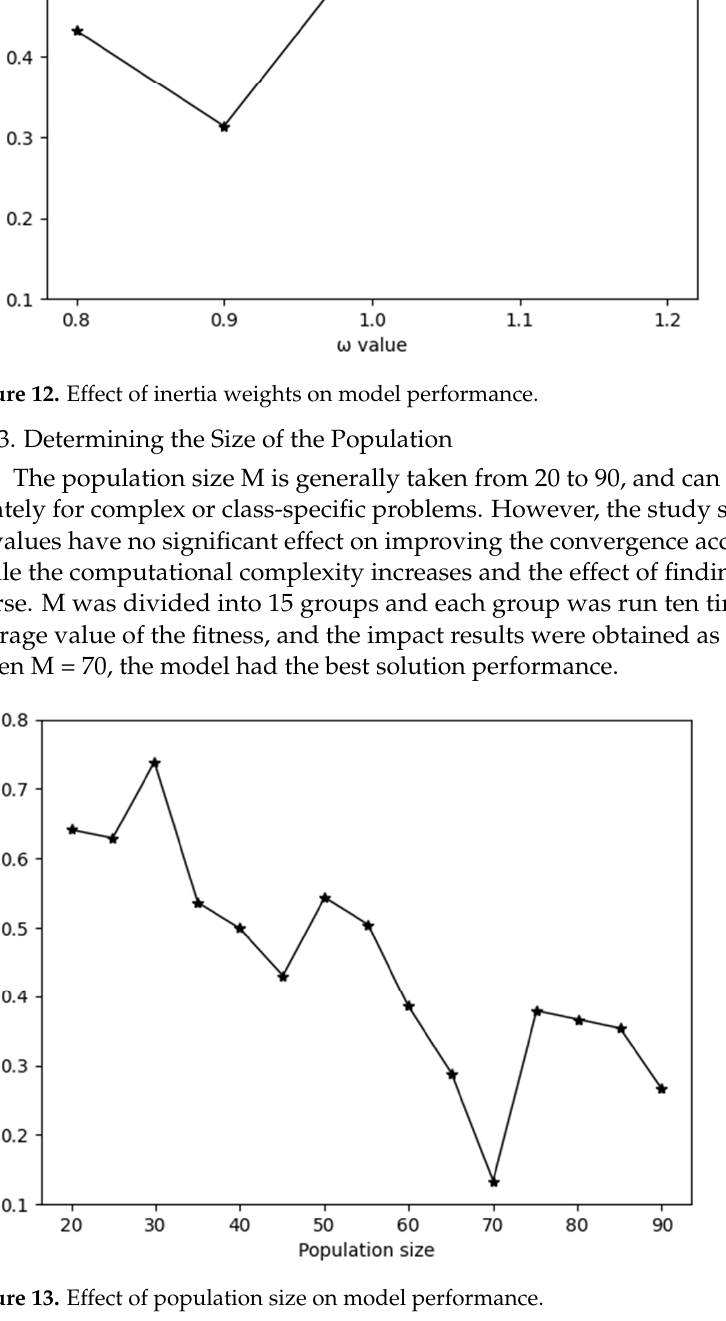
Figure 13. Effect of population size on model performance.